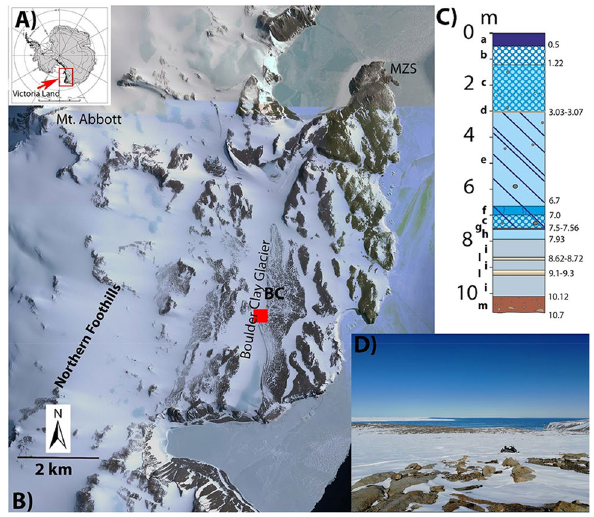
Figure 1. ( A ) Location map of the study area. ( B ) georeferenced satellite image with the location of the borehole (BC), the Italian Antarctic Station Mario Zucchelli (MZS) and some localities cited in the text. ( C ) Stratigraphy of the core (a, snow and firn; b) milky bubbly ice; c) bubbly ice with few clasts; d) well sorted frozen sand layer; e) clean ice with few clasts; f) ice with vertical tubules; g) ice with vertical tubules and black inclusions; h) clean ice; i) salty ice; l) salty slush (8.62–8.72) and brine (9.1–9.3); m) frozen till. ( D ) View of the borehole location from W to E.